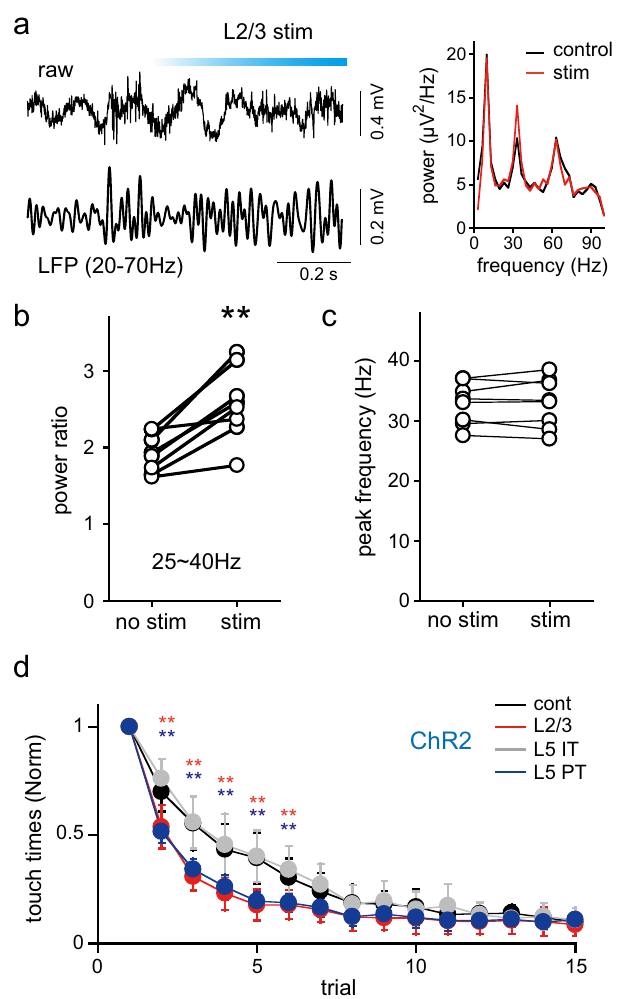
Fig. 7 Effects of selective stimulation of PC subtypes on oscillations and motor learning. a Raw trace (upper) and LFPs (lower), band-pass fi ltered between 20 and 70Hz, observed during the pattern learning task on day 1. L2/3 cells were stimulated by ramp-shaped light illumination. Right, power spectra of LFPs recorded in the presence and absence of light illumination. b Ratios of power at peak frequency between 25 and 45Hz to averaged power between 45 and 55Hz in the presence and absence of photostimulation (**, Wilcoxon signed-rank test, P = 0.0078, 8 rats). c Peak frequencies of LFP power spectra between 25 and 45Hz obtained during a learning task in the presence and absence of photostimulation (8 rats). d Effects of ChR2 photostimulation on learning progress. Number of touches by forelimbs to the foot fl oor normalized to that of the fi rst trial. Photostimulation was applied to both hemispheres of rats expressing ChR2 by electroporation at E17.5 (L2/3 PC, red, n = 12), E15.5 (IT, gray, n = 10), or E14.5 (PT, blue, n = 11). Rats implanted with cannulas and connected with an optical fi ber during trials, but without stimulation, were used as controls (black, n = 18). Note that learning was signi fi cantly accelerated by L2/3 and L5 PT cell stimulation. ** P < 0.001 in red for L2/3 vs. control and vs. IT, and in blue for PT vs. control and vs. IT (Bonferroni post hoc test). P values are shown in Supplementary Table 2. Data are expressed as means power of beta/gamma-band selectively (34.67 ± 0.16%, Wilcoxon signed-rank test, P = 0.0078, 8 rats, Fig. 7a, b). However, the peak frequency of this band did not shift during photostimulation (Fig. 7c). By contrast, the power of 60 – 70 Hz band did not change during stimulation (peak power and frequency, − 1.46 ± 9.37% and − 1.7 ± 4.2% change, respectively). Theta band activity was